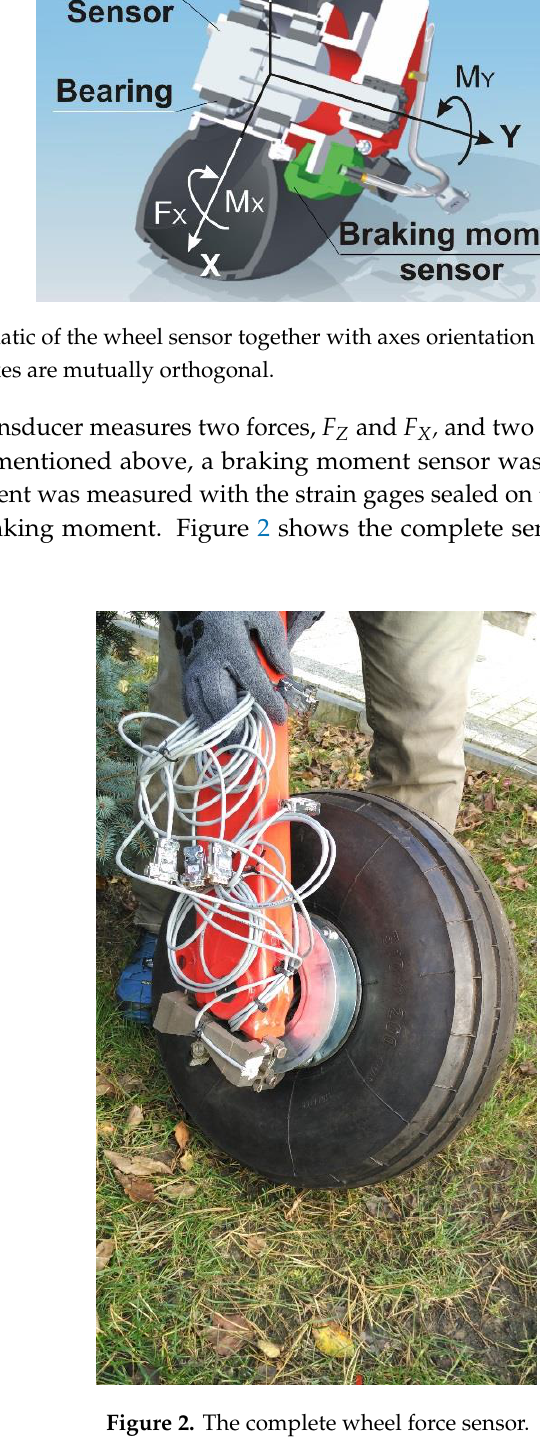
Figure 2. The complete wheel force sensor.